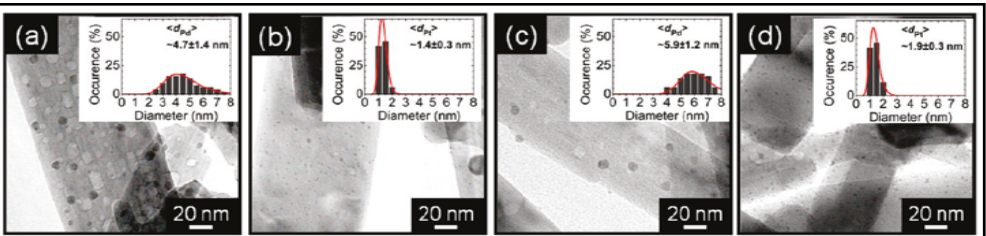
Figure 27. TEM images of ( a ) N-TiO 2 (A)-Pd NF, ( b ) N-TiO 2 (A)-Pt NF, ( c ) N-TiO 2 (B)-Pd NF, and ( d ) N-TiO 2 (B)-Pt NF. In each case, metal loading is ~1.0 wt.%. Insets show histograms of the corresponding metal nanoparticle size distribution. Reproduced with permission from reference [145].